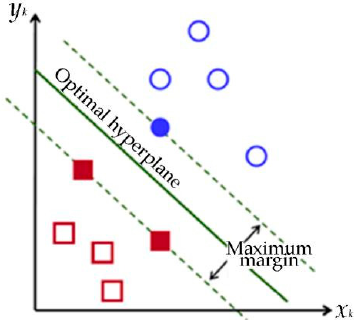
Figure 3. Concept of optimal hyperplane.